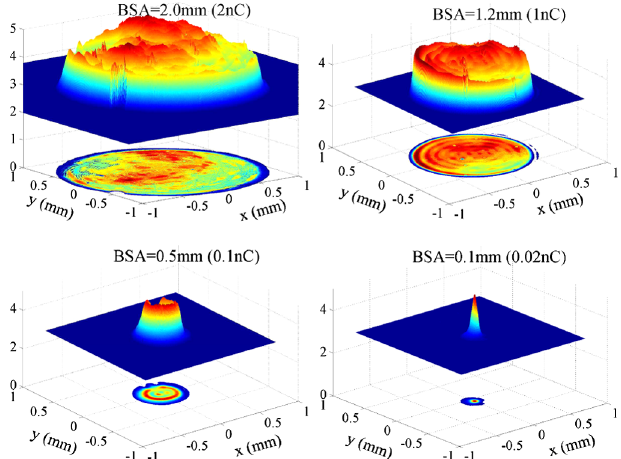
FIG. 6. Typical transverse distributions of the cathode laser for BSAs delivering optimum emittance values for given bunch charges. Laser intensity in arbitrary units is plotted on the vertical axis.